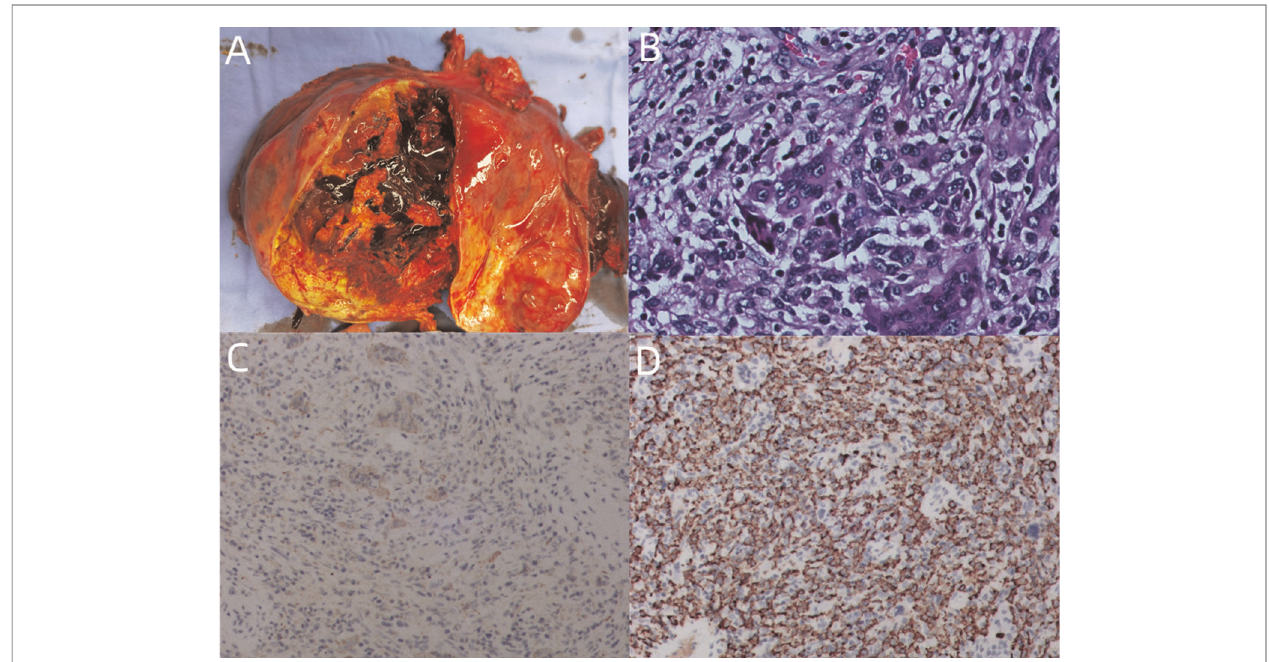
FIGURE 3 | ( A ) General specimen: The mass is nodular, appears to have a fi brous envelope, has a clear perimeter, and is about 10×10 cm in size. ( B ) Tumor tissue (hematoxylin – eosin staining ×200): Tumor cells under the microscope are seen to consist of a mixture of monocyte-like cells and a large number of osteoclast-like multinucleated giant cells, with mild dysplasia of the nucleus, no pathological nuclear division, accompanied by extensive bleeding and necrosis. ( C ) GCT-STs are positive for immunostain CD68 (immunoperoxidase ×100). ( D ) GCT-STs are positive for immunostain CD163 (immunoperoxidase ×100).